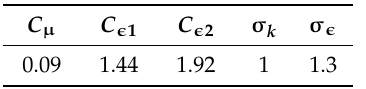
Table 1. k − (cid:101) model